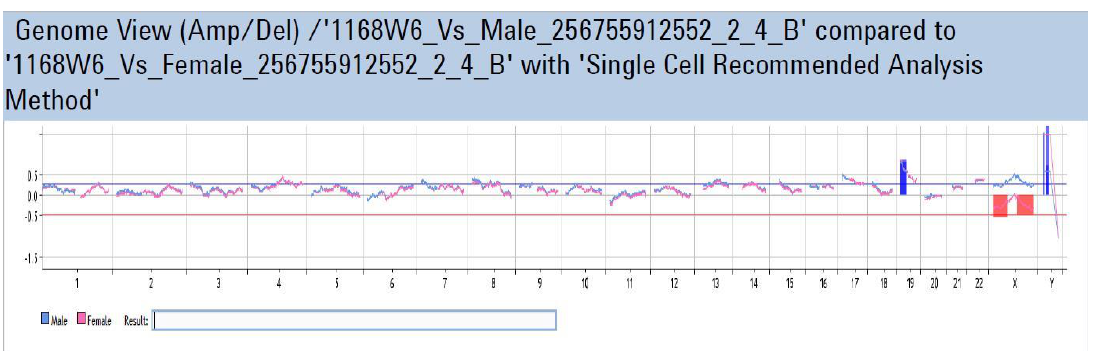
Figure A3. Male embryo, aneuploid, monosomy 10, monosomy 15, trisomy 20.